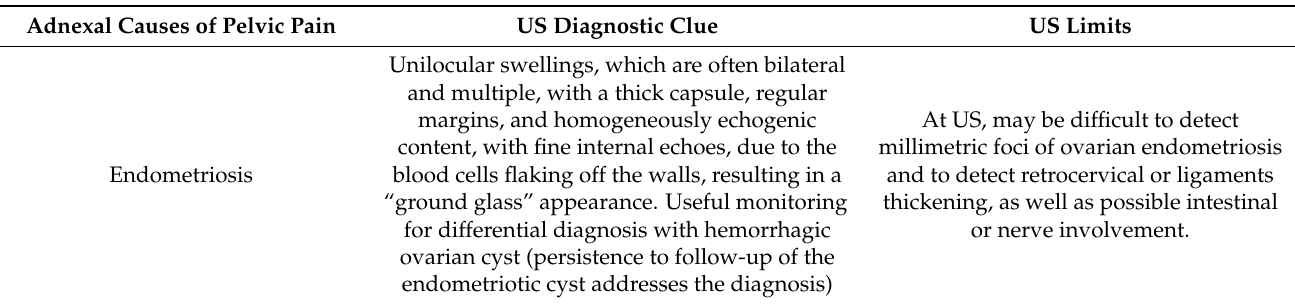
Table 7. Endometriosis US diagnostic clue.